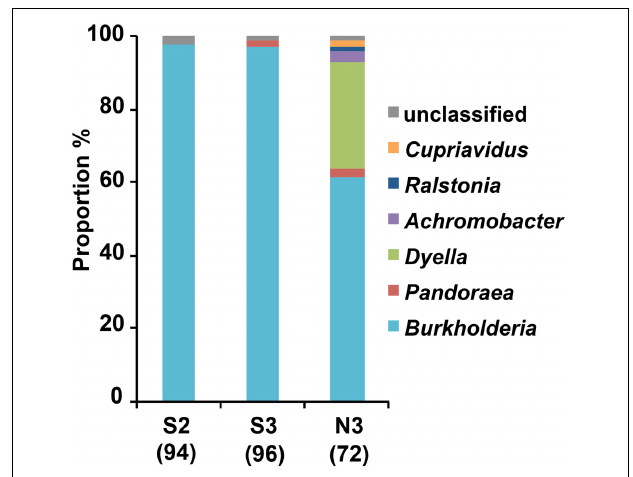
FIGURE 2 | Genus-level compositions of MEP-degrading bacteria isolated from MEP-sprayed soils. MEP-degrading isolates from soil S after two times and three times MEP spraying (S2 and S3, respectively) and from soil N after three times MEP spraying (N3) were identified by partial (c.a. 600bp) sequencing of 16S rRNA gene. Numbers in parentheses indicate total numbers of inspected MEP-degrading strains that were randomly selected from 2 pots in each soil (i.e., results of pots 1 and 2 are merged here). Sequences were subjected to taxonomic assignment by using RDP multiclassifier with a threshold level of